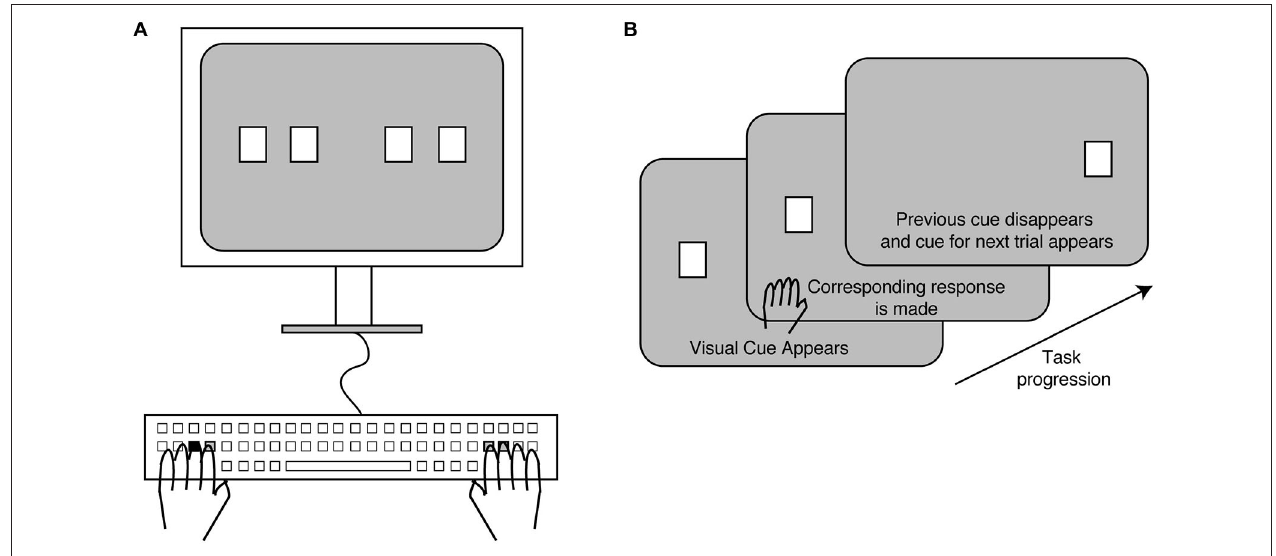
the left and right hands. The remaining keys were removed from the keyboard. (B) A trial began with one of the stimuli appearing on the screen. The corresponding key was pressed upon which the stimulus disappeared and the next stimulus was displayed in a new location.